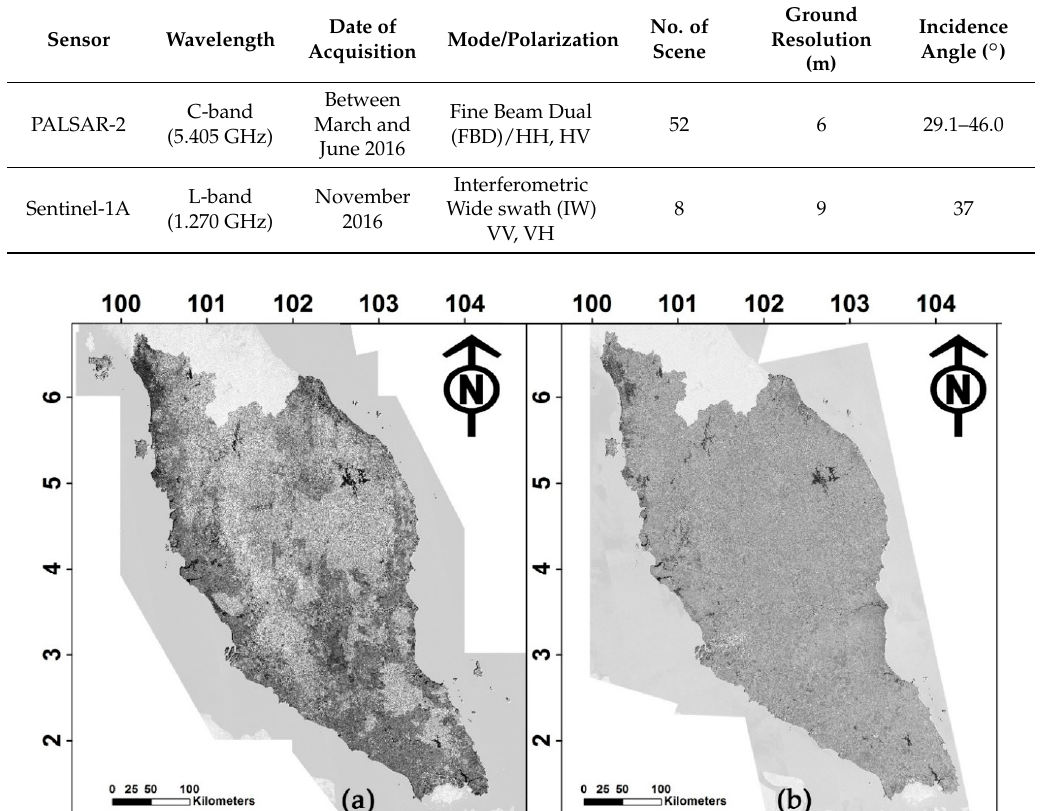
Table 1. Summary of satellite images used in this study.